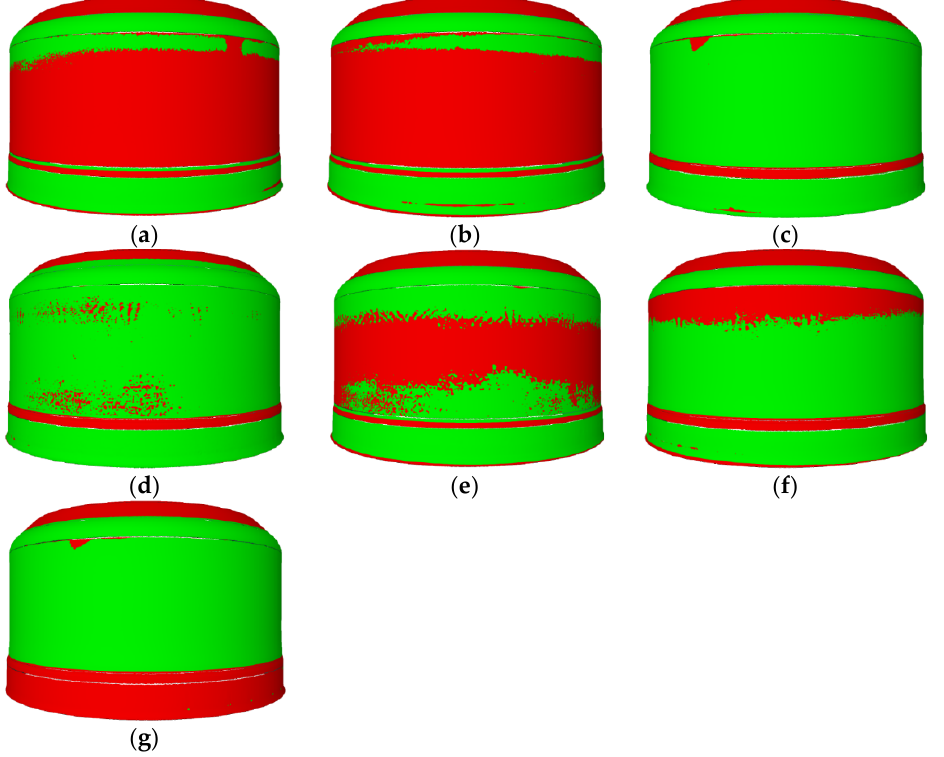
Figure 8. Areas of components after technological tests within given tolerances: P 0 ( a ), P 1 ( b ), P 2 ( c ), P 3 ( d ), P 4 ( e) , P 5 ( f ), and P 6 ( g ). P 3 ( d ), P 4 ( e ), P 5 ( f ), and P 6 ( g